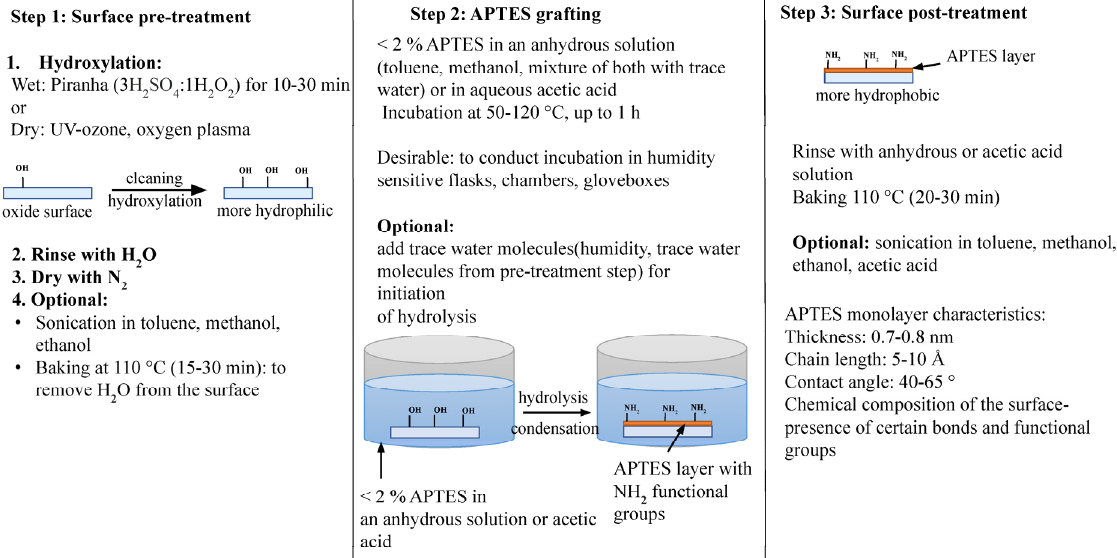
Figure 2. Solution-based APTES grafting on plain oxide surfaces. A general guideline for making APTES monolayers.